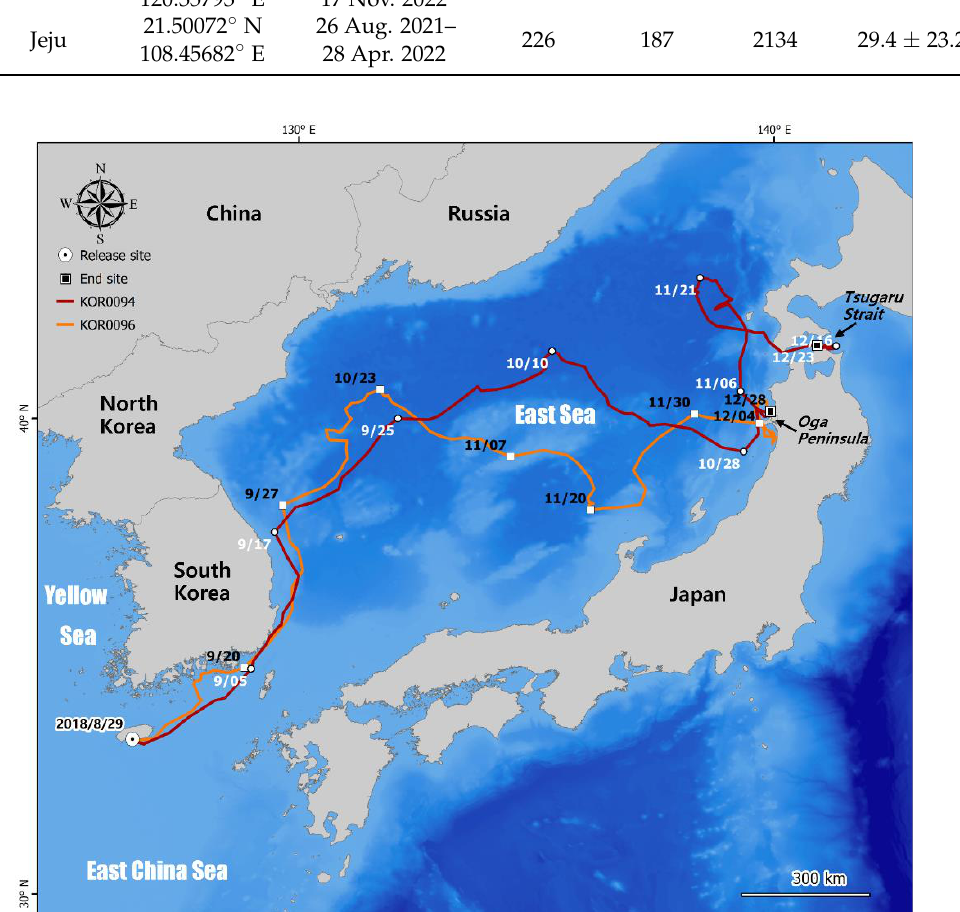
Figure 1. Travel routes of satellite-tracked loggerhead turtles KOR0094 and KOR0096.